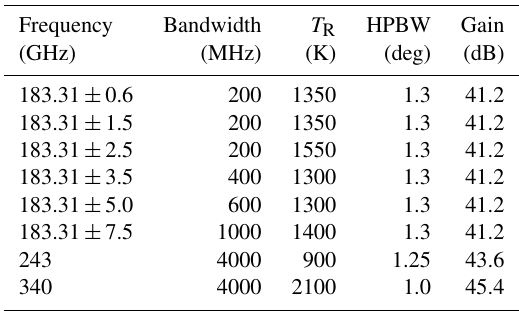
Table 2. Specifications of